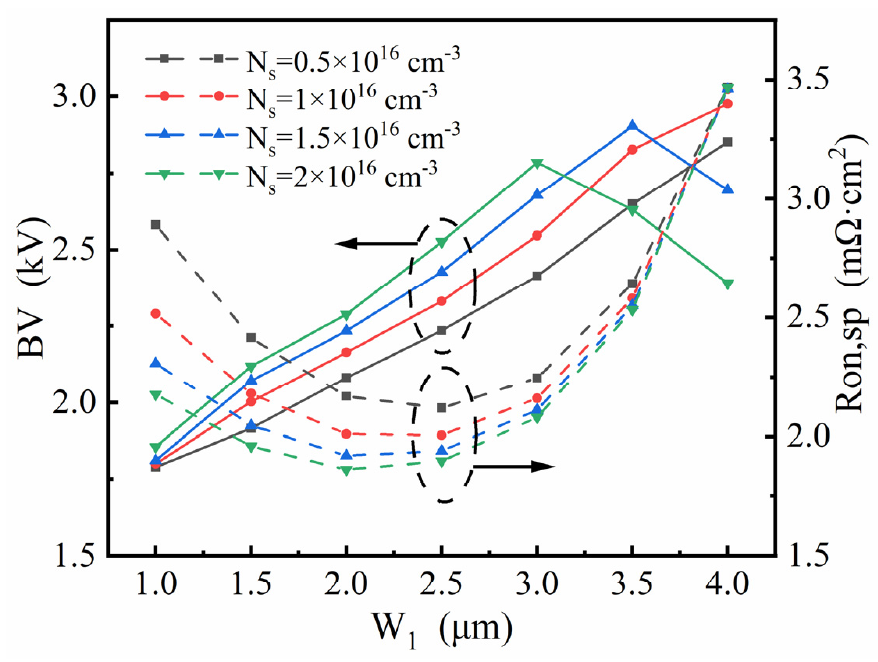
Figure 9. Investigation of W 1 affecting optimized BV and R on,sp in SDS-Trench CAVET for varied values of N s for a given N 1 = 1 × 10 16 cm − 3 .